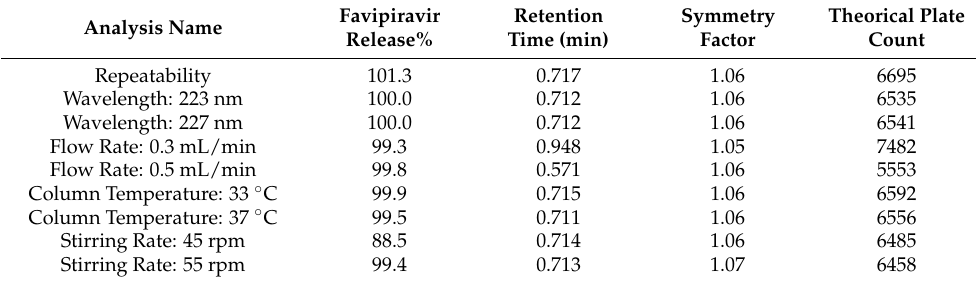
Table 9. Results of robustness.